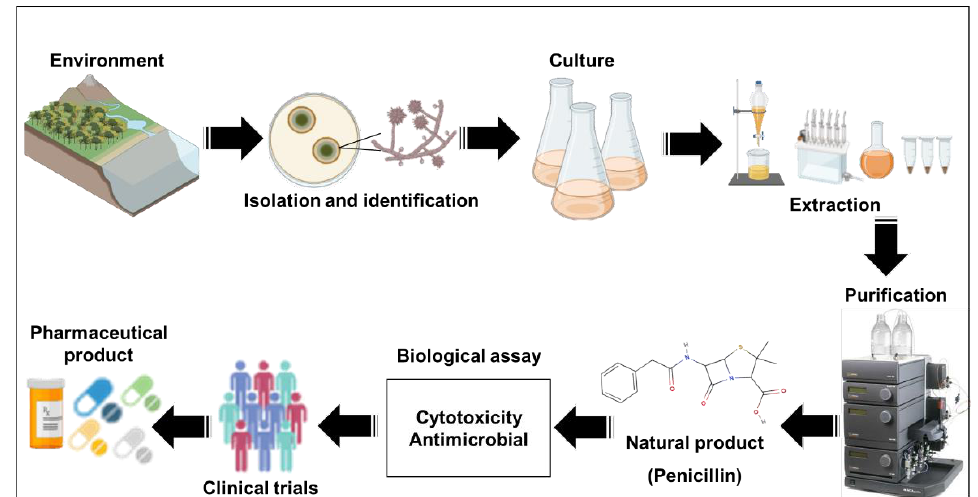
Figure 2. Representation of fungal strain isolation and development of medicines containing natural products as the bioactive component. Penicillin is being used just as an example.